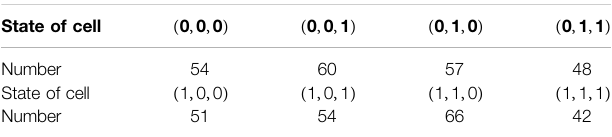
TABLE 3 | Number of initial states of cells.